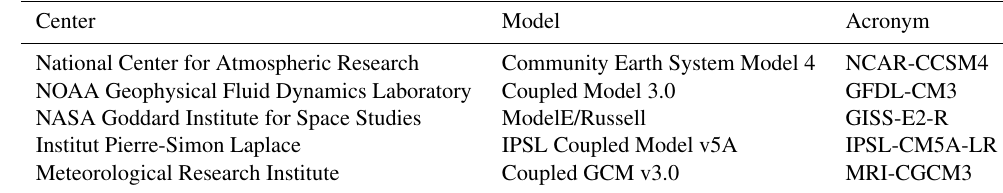
Table 2. Summary of the SNAP-selected climate